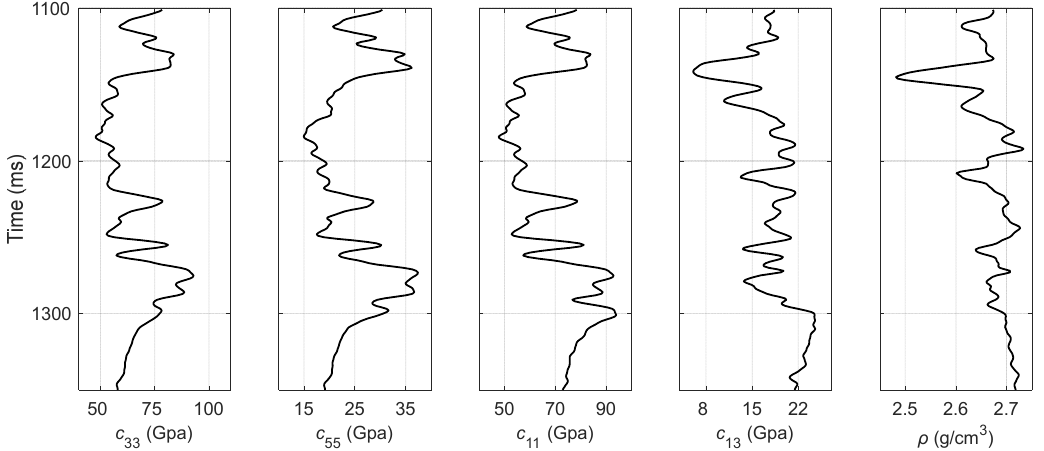
Figure 14. Well logs of the target layer. The panels from left to right give the true values of four sti ff ness parameters of c 33 , c 55 , c 11 , and c 13 , and density ρ . Table 4. Correlation coefficients of the inversion results by seismic traces near the well in Figures 13 and 14 and the real logs.